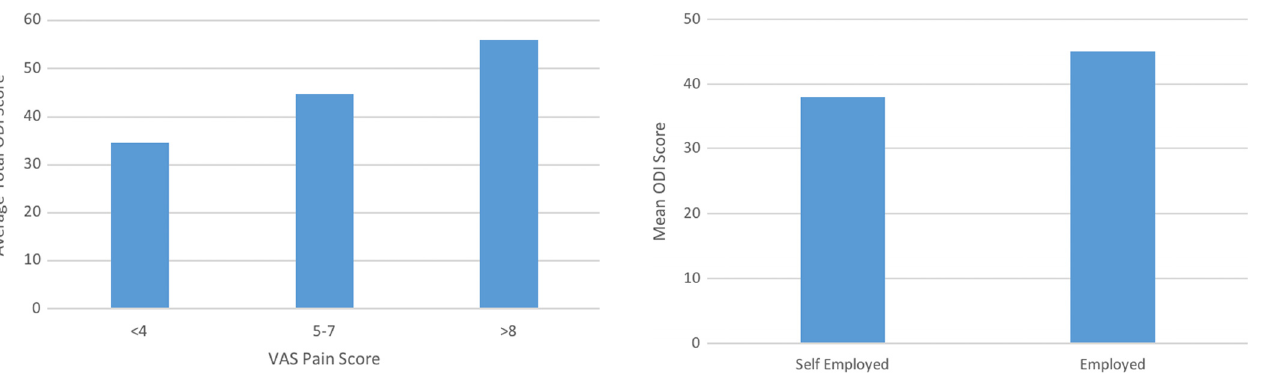
Figure 2. Graph comparing VAS pain score with average total ODI score.